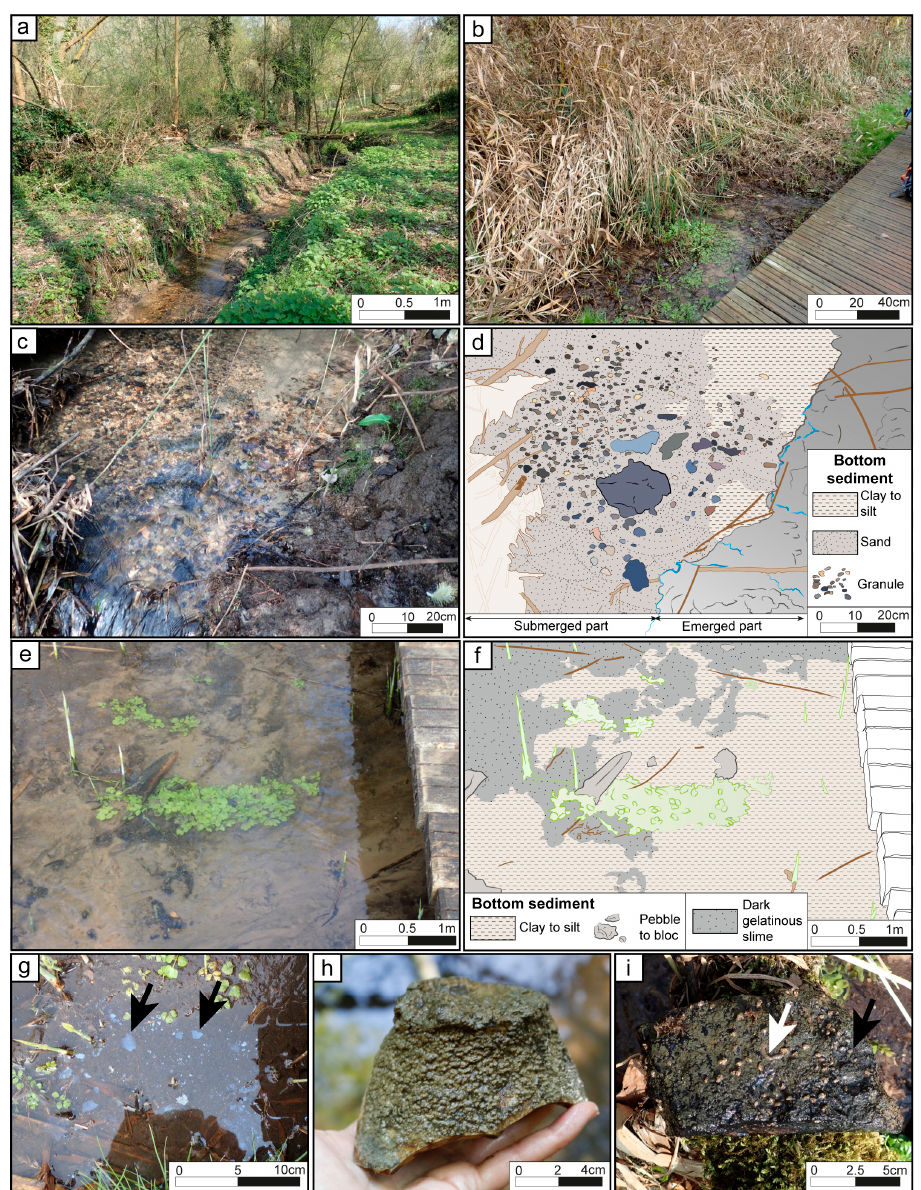
Figure 9. Main characteristics of Zone 2 from the forest to the footbridge (see Figure 2 for exact location). ( a ) Single, deep (70 cm to 1 m) channel in the forest-dominated zone; ( b ) shallow (less than 15 cm) multiple channels flowing through the reed bed; ( c ) view and ( d ) drawing of the bottom sediments of the forest-zone dominated by sand size; ( e ) view and ( f ) drawing of the bottom sediment of the zone reed-dominated by mud to silt size with few pebble and blocks, dark gelatinous slime covering soft substrate; ( g ) patchy white biofilms in the reed bed zone (black arrows); ( h ) fragment of pottery covered by a mm-thick pustular tufa microbialite; ( i ) substrate covered by thin, patchy blue–green biofilms with Trichoptera pupal cases (black arrow) and larval housings (white